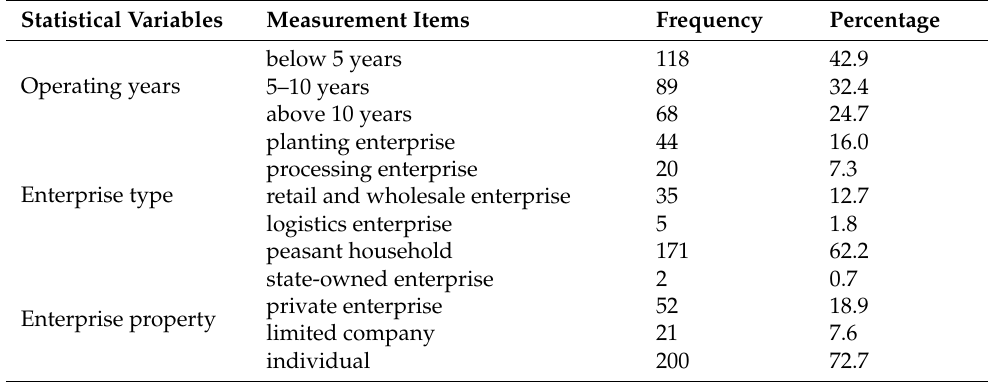
Table 1. Demographic characteristics of the